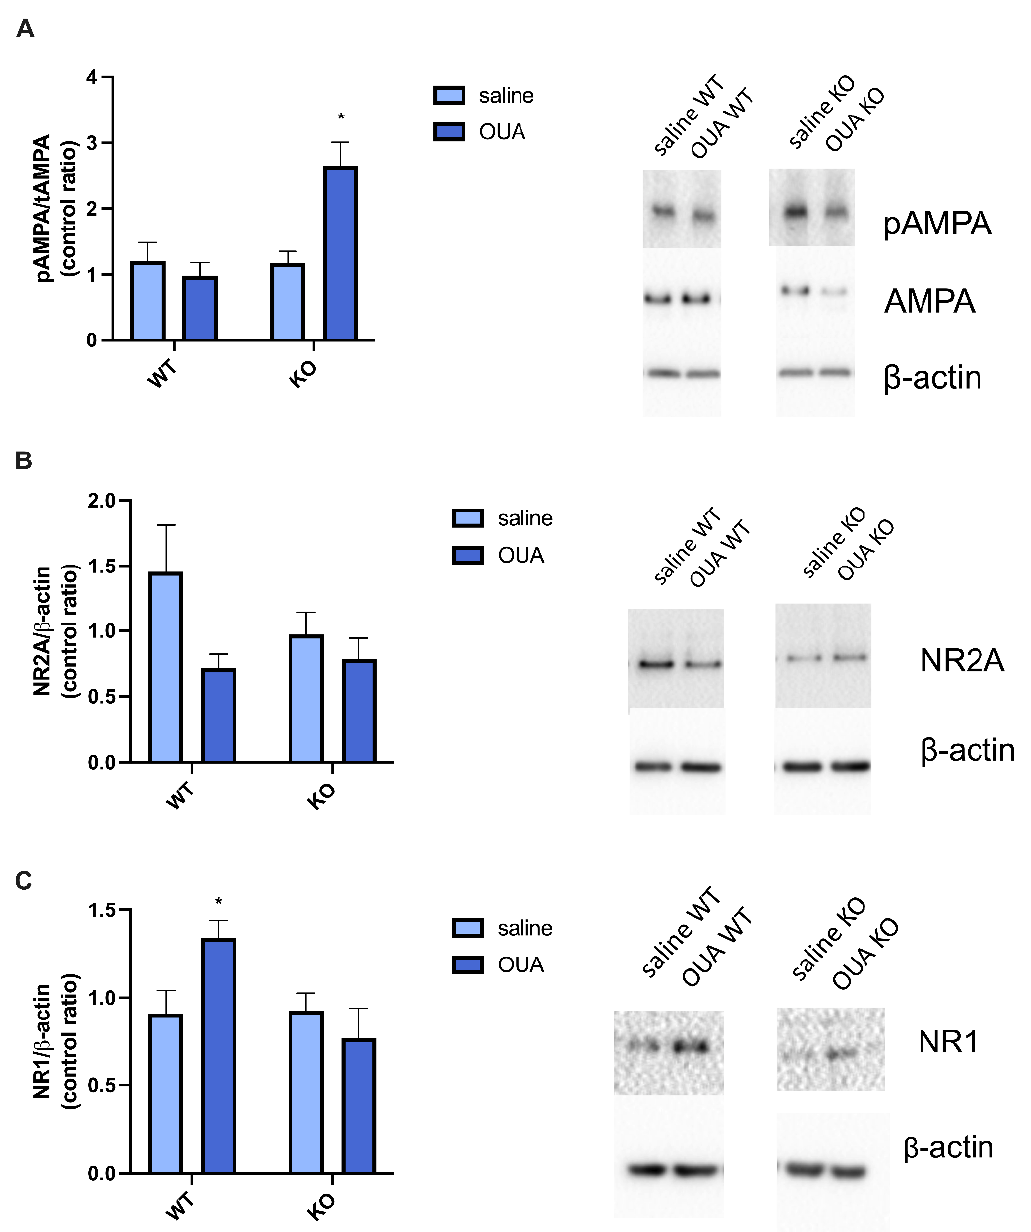
Figure 4. Ouabain causes changes in AMPA receptor phosphorylation, NR1 and NR2 membrane expression. ( A ) Densitometric analysis and representative Western blotting of phosphorylation ratio of AMPA receptor. Ouabain in TNFR1 KO mice is increased in comparison to all the other groups * vs. saline WT, saline KO, and OUA WT (* p < 0.05). ( B ) Densitometric analysis and representative Western blotting of NR2 membrane expression. NR2 expression is decreased for the ouabain factor [F (1, 14) = 5067]. ( C ) Densitometric analysis and representative Western blotting of NR1 membrane expression. Ouabain in WT mice increases NR1 levels in comparison to TNFR1 treated with ouabain, * vs. OUA KO (* p < 0.05). Results are expressed in the phosphorylation ratio for AMPA receptor ( n = 4, N = 2), in control ratio for NR2 ( n = 4, N = 2), and for NR1 ( n = 7, N = 2). The samples were analyzed by two-way ANOVA followed by Tukey’s